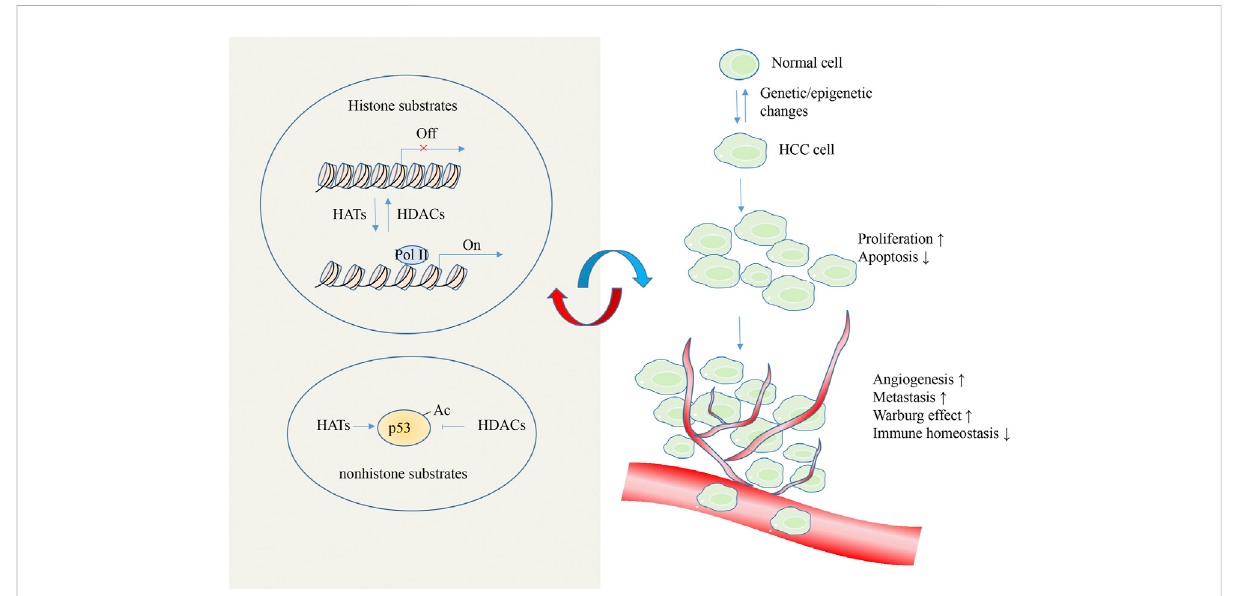
FIGURE 2 RolesofHATs/HDACsinHCC.AberrantHATs/HDACs-mediatedhistoneacetylationtriggeroncogenesactivation,andlossintumorsuppressor geneexpressiontoleadtheHCCestablishment.p53wastherepresentativenon-histoneproteinthatshowntobeacetylated/deacetylatedbyHATs/ HDACs, and this type of modi fi cation is essential for p53 activity in HCC. In turn, the metabolic product from HCC also in fl uence the acetylation modi fi